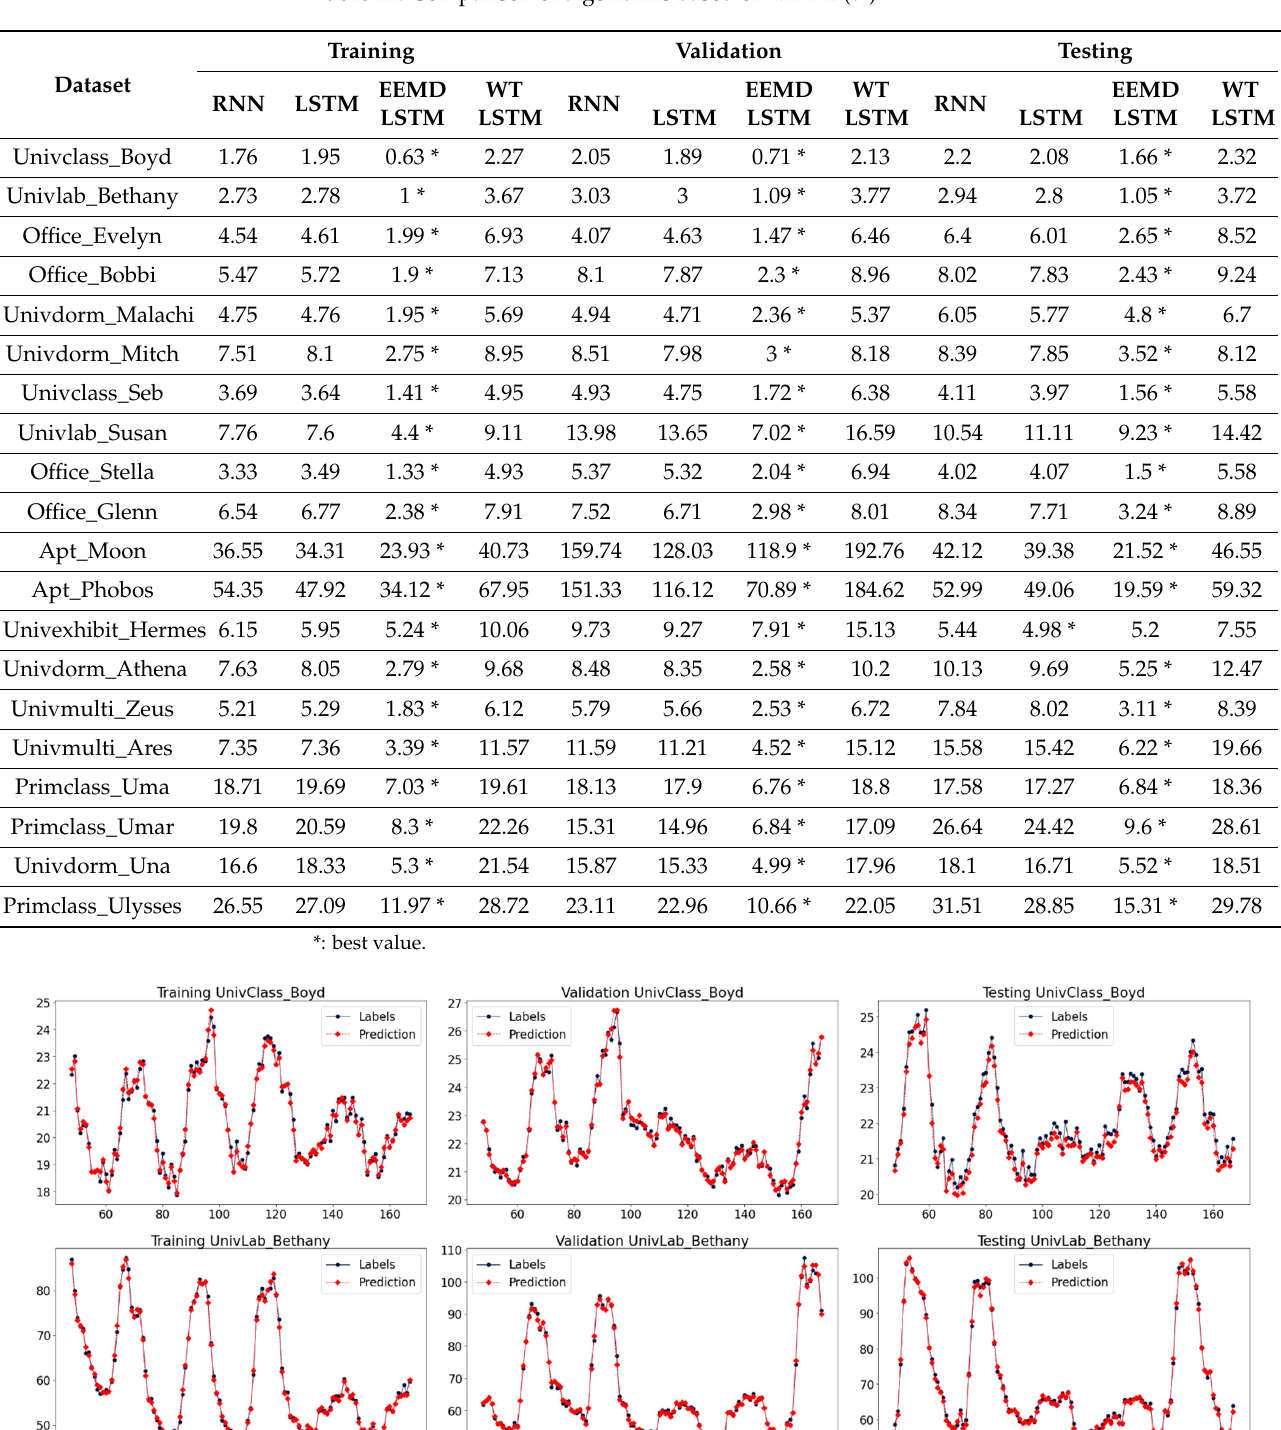
Table 11. Comparison of algorithms based on MAPE (%).